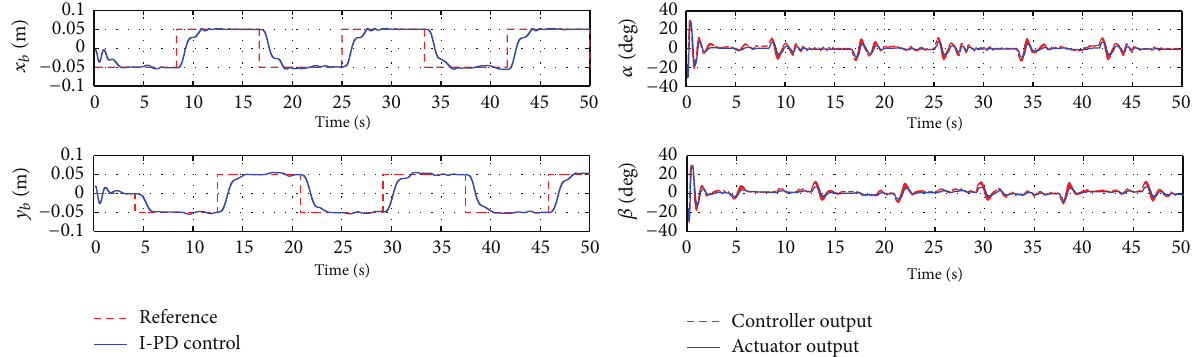
Figure 12: Experimental results of square response.